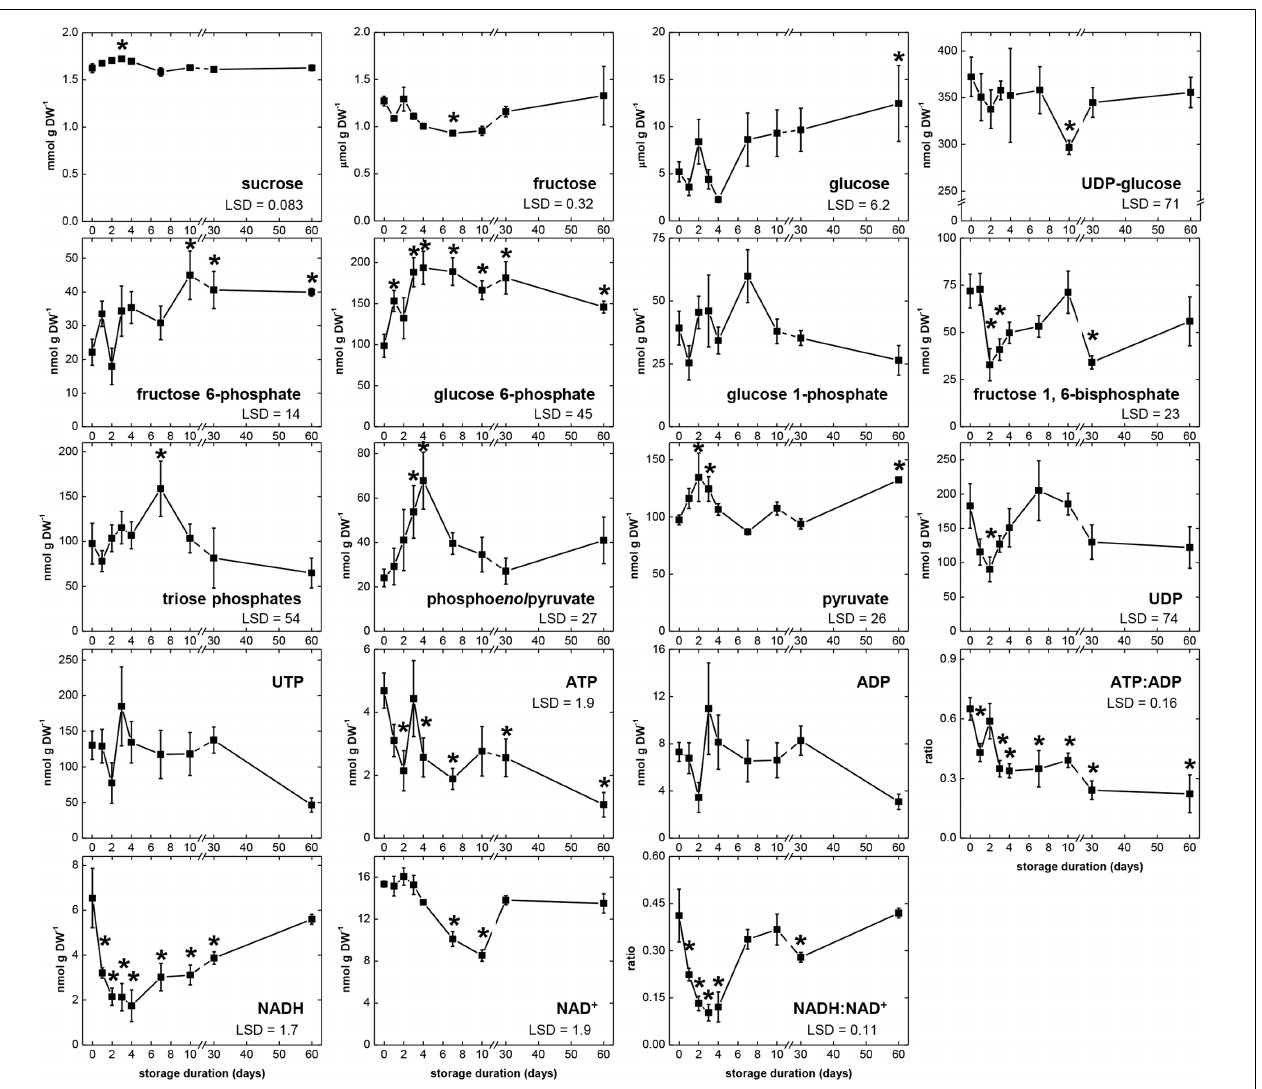
FIGURE 4 | Concentrations of glycolytic pathway metabolites, ATP:ADP ratio, and NADH:NAD + ratio during 60 days storage. Roots were stored for 10 days at 10 ◦ C and 90 ± 5% RH, then stored at 4 ◦ C, 90 ± 5% RH for 50 days. Concentrations are expressed per gram dry weight. ATP:ADP ratio is provided as a measure of cellular energy status. NADH:NAD + ratio is provided as a measure of cellular redox status. Error bars are ± 1 standard error of the mean, where n = 7. Fisher’s LSDs are provided in lower left corner of graphs with α = 0.05. Asterisks denote data that are significantly different from that at 0